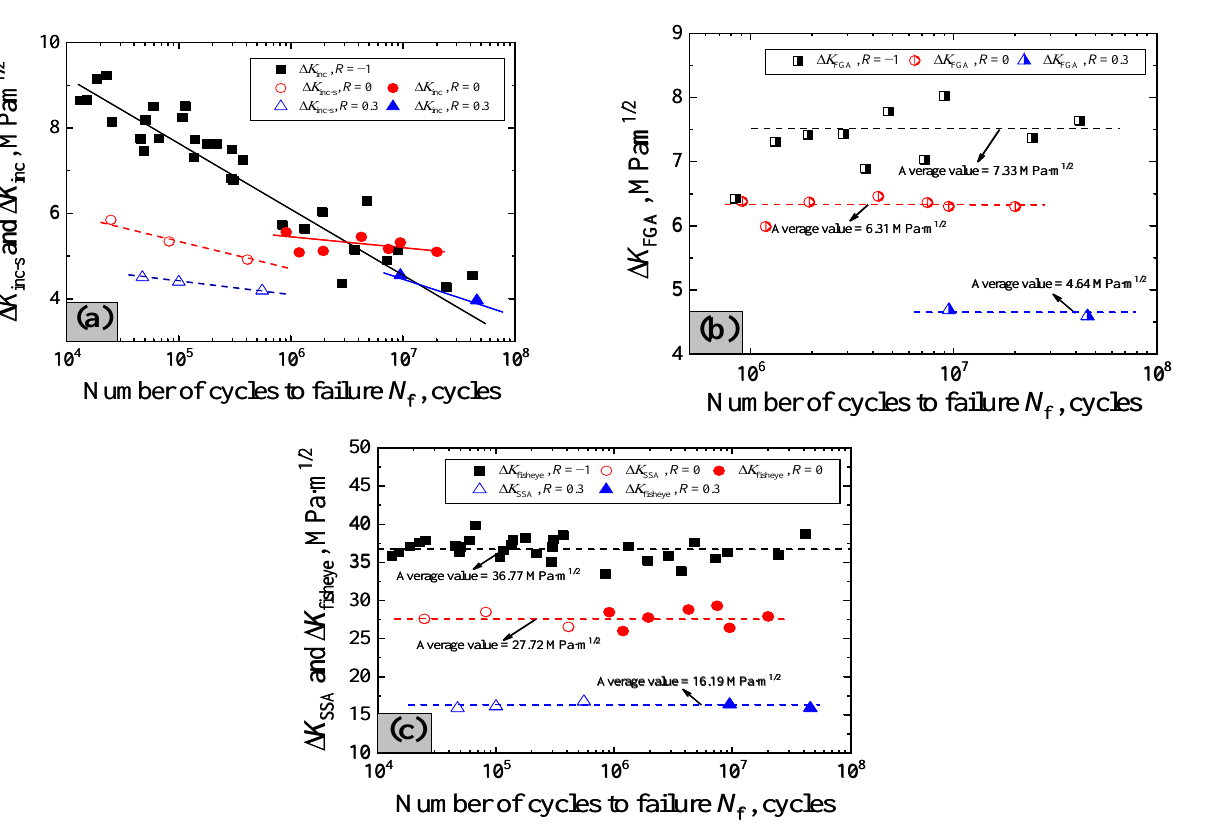
Figure 7. Relationship between ∆ K and N f: ( a ) relationship between ∆ K inc-s , ∆ K inc and N f; ( b ) relationship between ∆ K FGA and N f; and ( c ) relationship between ∆ K SSA , ∆ K fisheye and N f. Since ∆ K FGA , ∆ K fisheye and ∆ K SSA are independent of the fatigue life of carburized Cr-Ni gear steel and show horizontal fitting lines, the sizes of FGA, fisheye and SSA can be evaluated by means of the internal long crack propagation threshold and the instability propagation threshold of carburized Cr-Ni gear steel, respectively. Namely: 2 FGA or fisheye